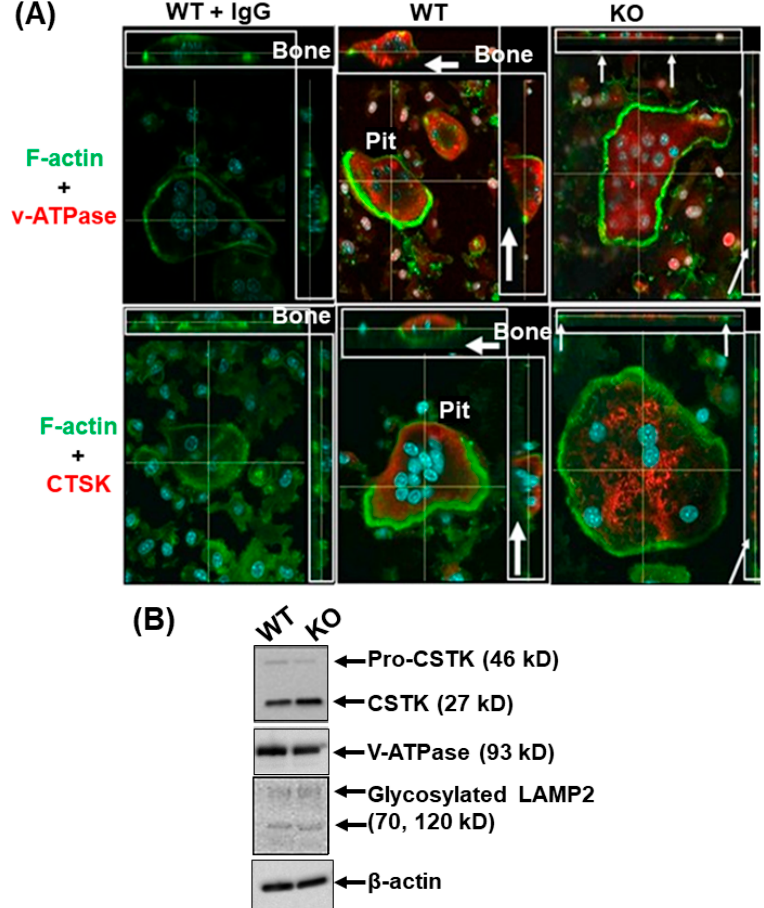
Figure 3. LRRK1-de fi cient osteoclasts cannot localize cathepsin K (CTSK) and V-ATPase to the ruf- fl ed border. ( A ) Di ff erentiated osteoclasts on bone slices were probed with monoclonal anti-CTSK from mouse and polyclonal anti-V-ATPase antibodies from rabbit or corresponding control IgG, respectively, followed by staining with rhodamine-conjugated second antibody. F-actin of the osteoclasts was stained with Alexa fl uor-488-conjugated phalloidin. Nuclei were stained with DAPI. Immuno fl uorescent staining was analyzed by a confocal microscope. The two lines in the middle of the cell represent the positions of horizontal and vertical cuts, respectively. Arrows indicate F-actin and CTSK, and V-ATPase, respectively, associated with a pit on the horizontal and vertical cross-sections of WT but not LRRK1-de fi cient osteoclasts. ( B ) Monoclonal antibodies against CTSK and LAMP-2, and polyclonal antibodies speci fi c to v-ATPase, were validated by Western blot. Comparable levels of CTSK, v-ATPase, and LAMP-2 were expressed in LRRK1-de fi cient and WT control osteoclasts.